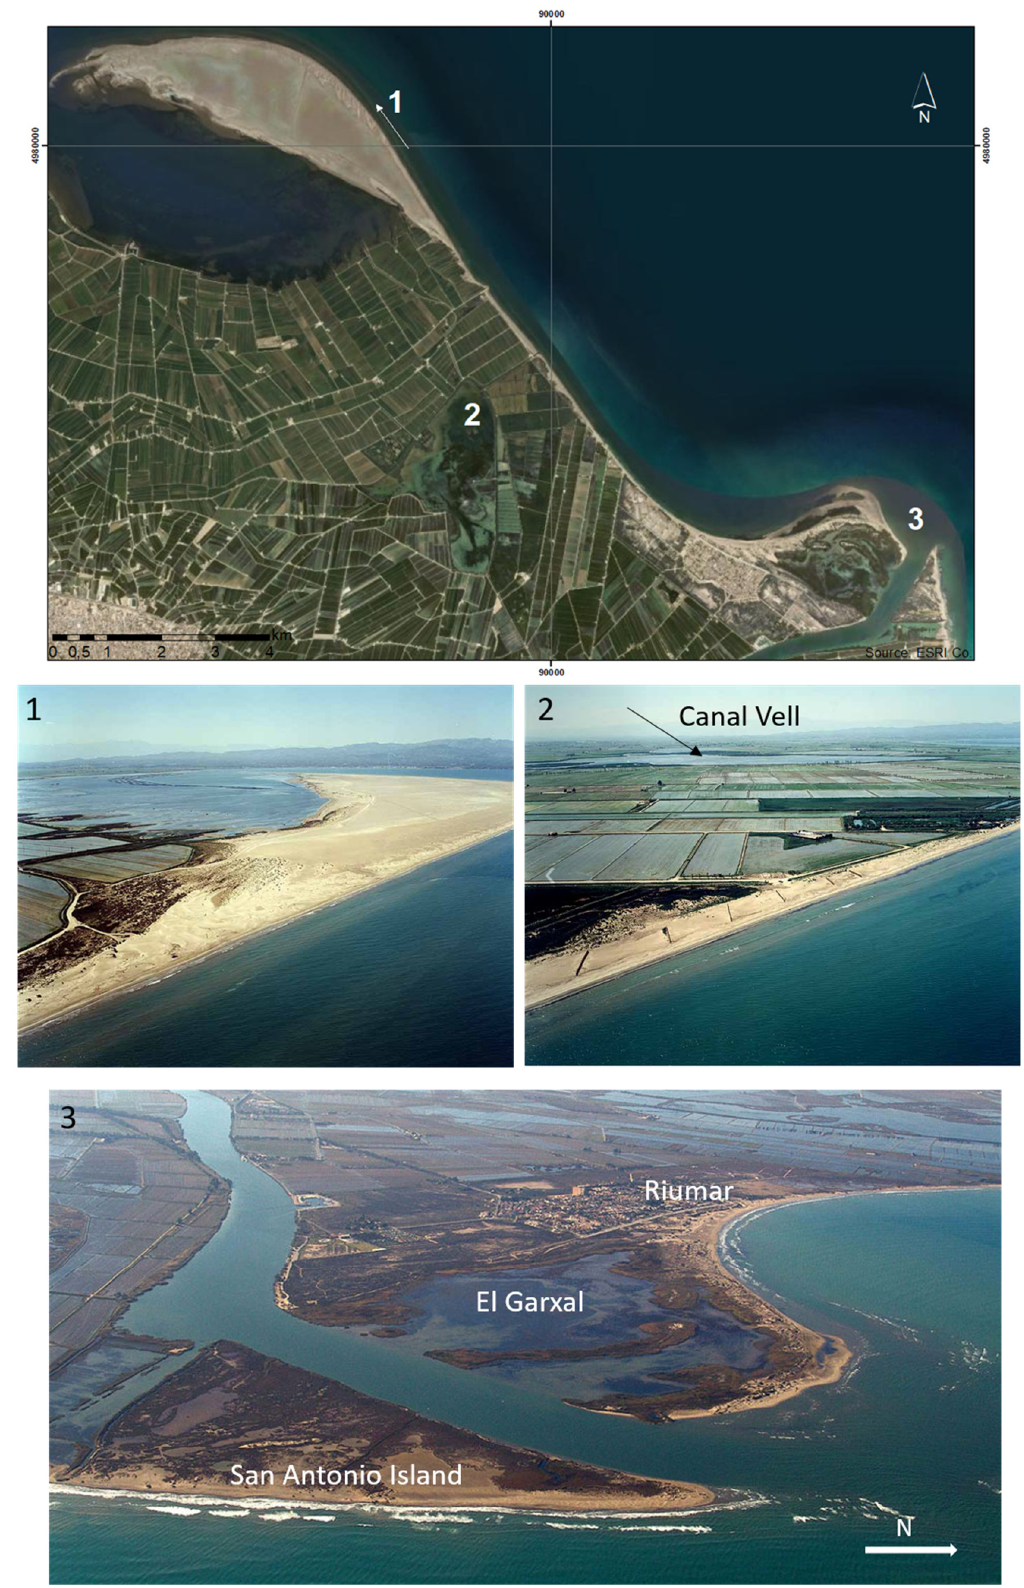
Figure 2. Images of the hemidelta north and mouth. ( 1 ) El Fangar Spit; ( 2 ) Balsa de l’Estella or Estany del Canal Vell; ( 3 ) Riumar Beach, El Garxal Lagoon and San Antonio Island. (Source: General view: ESRI Co.; Photographs 1, 2 and 3: Guide of beaches of the Ministry for the Ecological Transition and the Demographic Challenge).